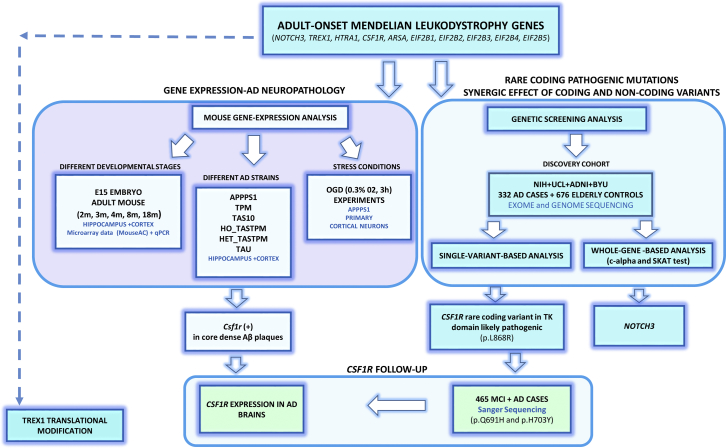
Pipeline followed in the adult-onset leukodystrophy gene study. Abbreviations: AD, Alzheimer's disease; BYU, Brigham Young University; MCI, mild cognitive impairment; TK, tyrosine kinase; NIH, National Institutes of Health; UCL, University College London.